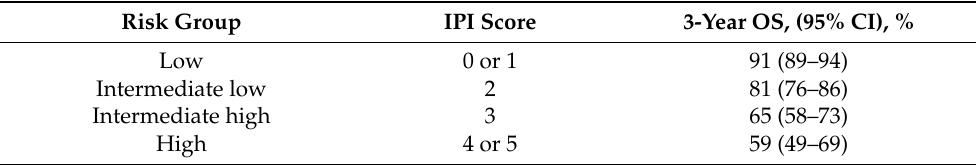
Table 2. International Prognostic Index. 1 score for each: Stage III–IV, elevated Lactate Dehydrogenase,